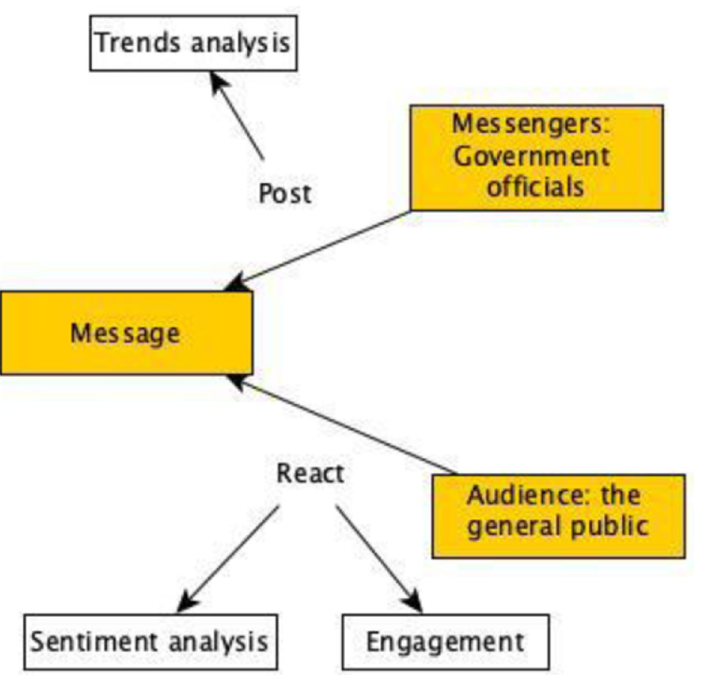
Fig 1. Conceptual model of the proposed